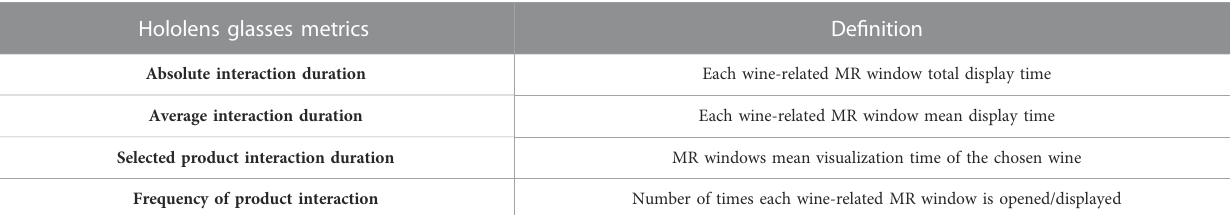
TABLE 1 Metrics of interest collected during the purchase experience with smart glasses.